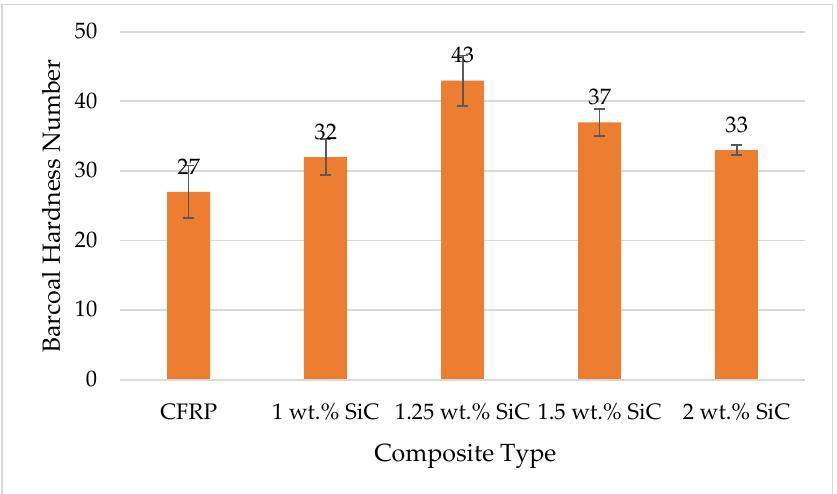
Figure 14. Barcol hardness number of CFRP and SiC hybrid nano-composites.